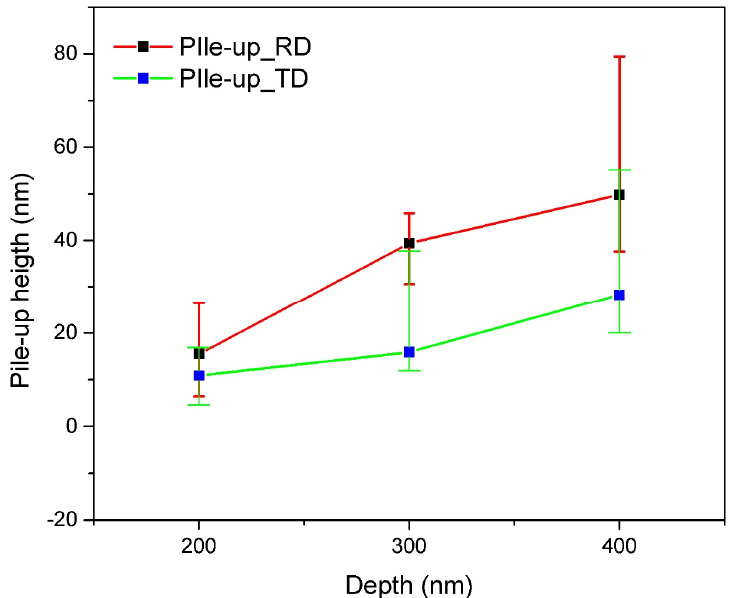
Figure 9. The figure depicts the pile-up heights along the TD and RD of Cu(16)/Nb(16) ARB nanolaminate. Indention depths used for the comparison of pile-up heights are 200, 300, and 400 nm,